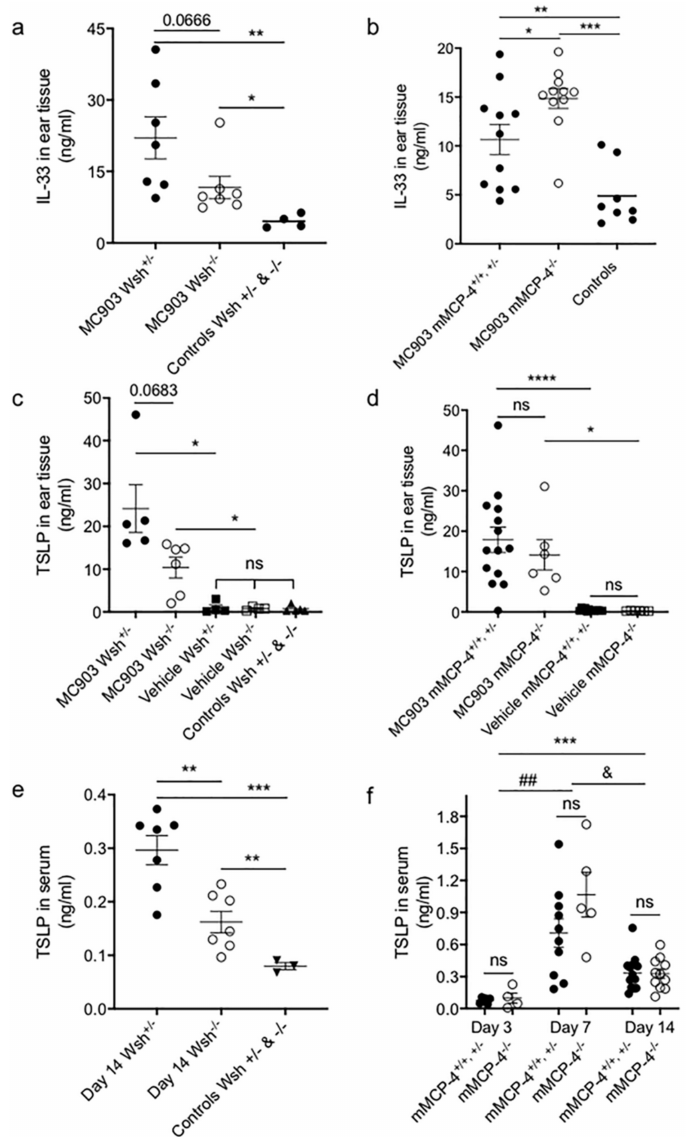
Figure 4. Treatment with MC903 increases production of IL-33 and thymic stromal lymphopoetin (TSLP). In age matched 6–9 weeks old littermate mice, the MC903 treatment ( a ) decreased the ear tissue levels of IL-33 level in the Wsh − / − mice and ( b ) significantly increased IL-33 levels in the mMCP-4 − / − mice as compared to the mMCP-4 +/+ , +/ − mice. MC903 treatment increased TSLP levels in ear tissue ( c , d ) and in serum ( e , f ) as compared to vehicle treated Wsh +/ − and mMCP-4 +/+ , +/ − littermate mice and non-treated littermate controls. Note that c-kit deficiency reduces the MC903-induced TSLP levels. In figure panels ( a – e ) * p < 0.05, ** p < 0.01, *** p < 0.001 and **** p < 0.0001, and in figure